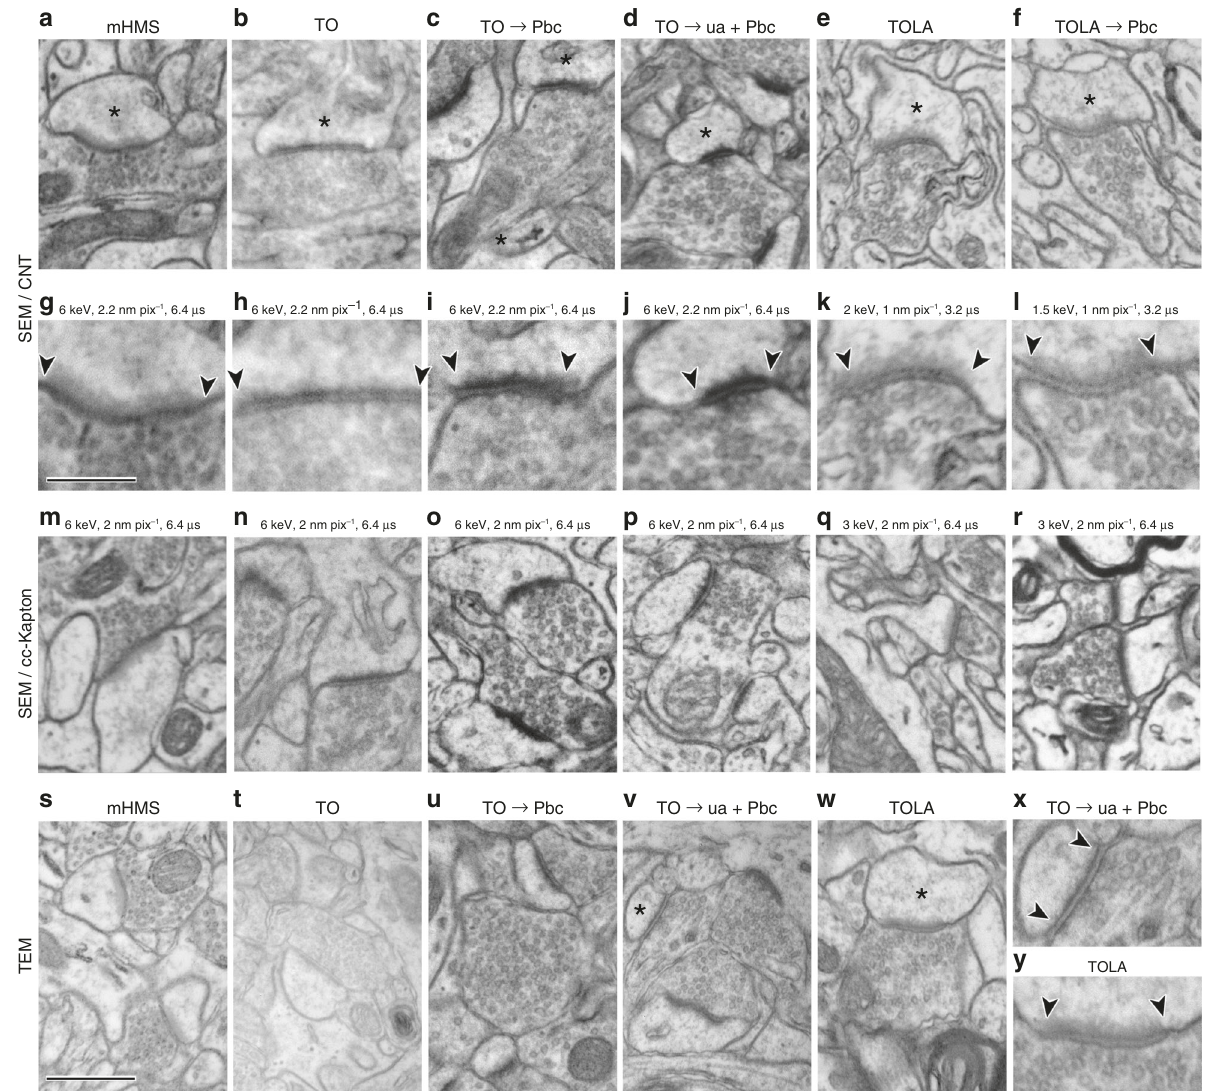
Fig. 5 Different metal staining protocols make a difference in image quality of ultrathin sections, but images obtained with SEM or TEM are comparable. a – l Images of ultrathin sections of a mHMS, b TO, c TO with lead citrate (Pbc) section staining, d TO with uranyl acetate (ua) and lead citrate section staining, e TOLA, and f TOLA with lead citrate section staining on CNT-coated PET tape captured with a BSD. g – l Enlarged image showing synaptic junction in a – f , where postsynaptic spine heads are marked with an asterisk. Synaptic junction area is indicated with arrowheads. Scale in g , 0.25 µ m, is for h – l , x , y . m – r Images of ultrathin sections of m mHMS, n TO, o TO with lead citrate section staining, p TO with uranyl acetate and lead citrate section staining, and q TOLA, and r TOLA with lead citrate section staining on cc-Kapton tape captured with a BSD. s – w Images of ultrathin sections of s mHMS, t TO, u TO with lead citrate section staining, v TO with uranyl acetate and lead citrate section staining, and w TOLA captured with TEM. Postsynaptic spine heads in v and w are marked with an asterisk. ( x and y ) Enlarged image showing synaptic junction of v and w . The synaptic junction area is marked with arrows. Scale in s